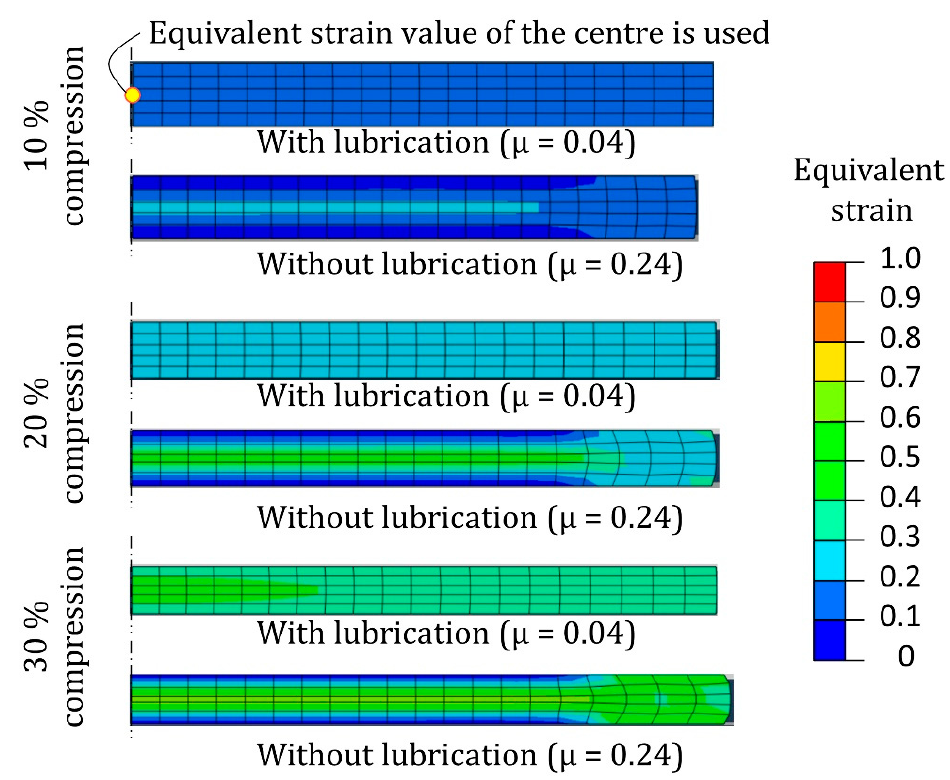
Figure 13. Calculated distribution of the equivalent strain after compression.